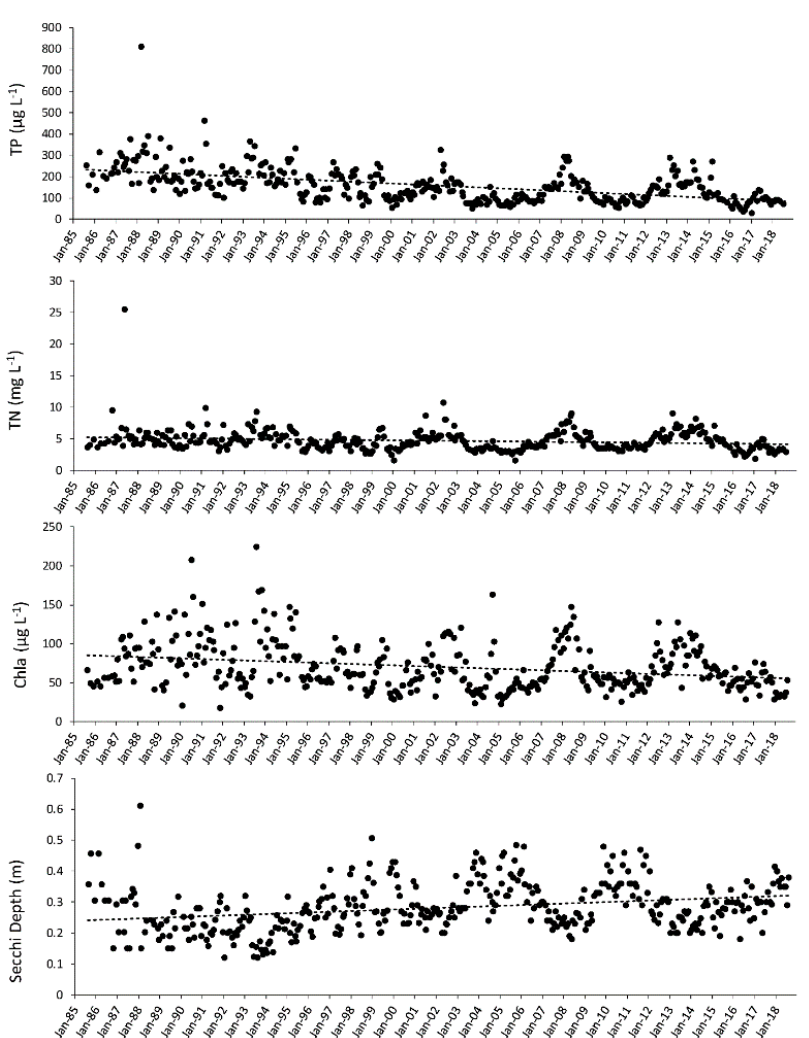
Figure 3. The long-term trends in water quality. All the trends are significant ( p < 0.001). TP: total phosphorus, TN: total nitrogen, chl-a: chlorophyll-a.